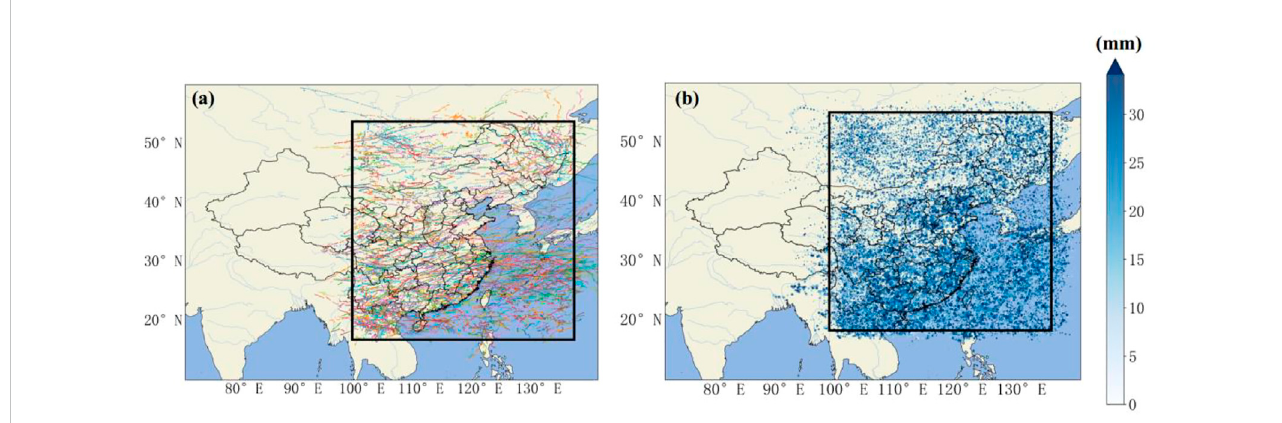
FIGURE 1 Object of study: (A) the trajectory of convective clouds studied; (B) maximum instantaneous precipitation in the MCS